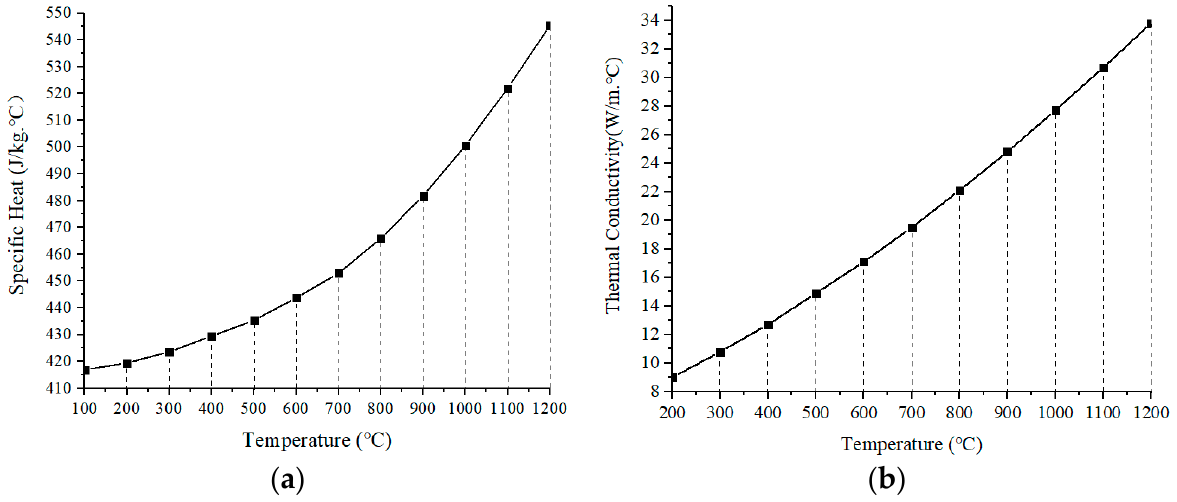
Figure 4. The thermophysical parameters of the material DD406: ( a ) Specific heat, ( b ) Thermal conductivity.